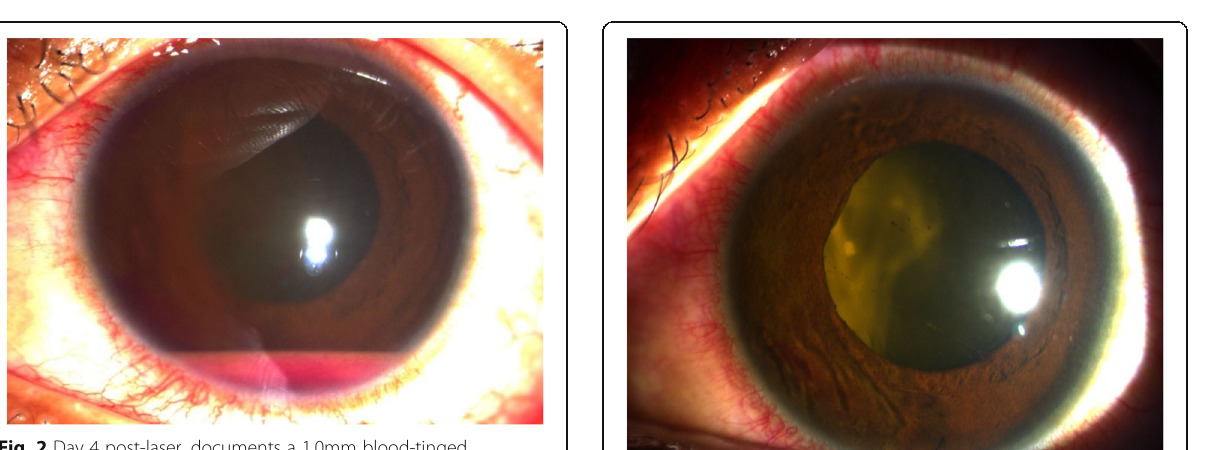
Fig. 2 Day 4 post-laser, documents a 1.0mm